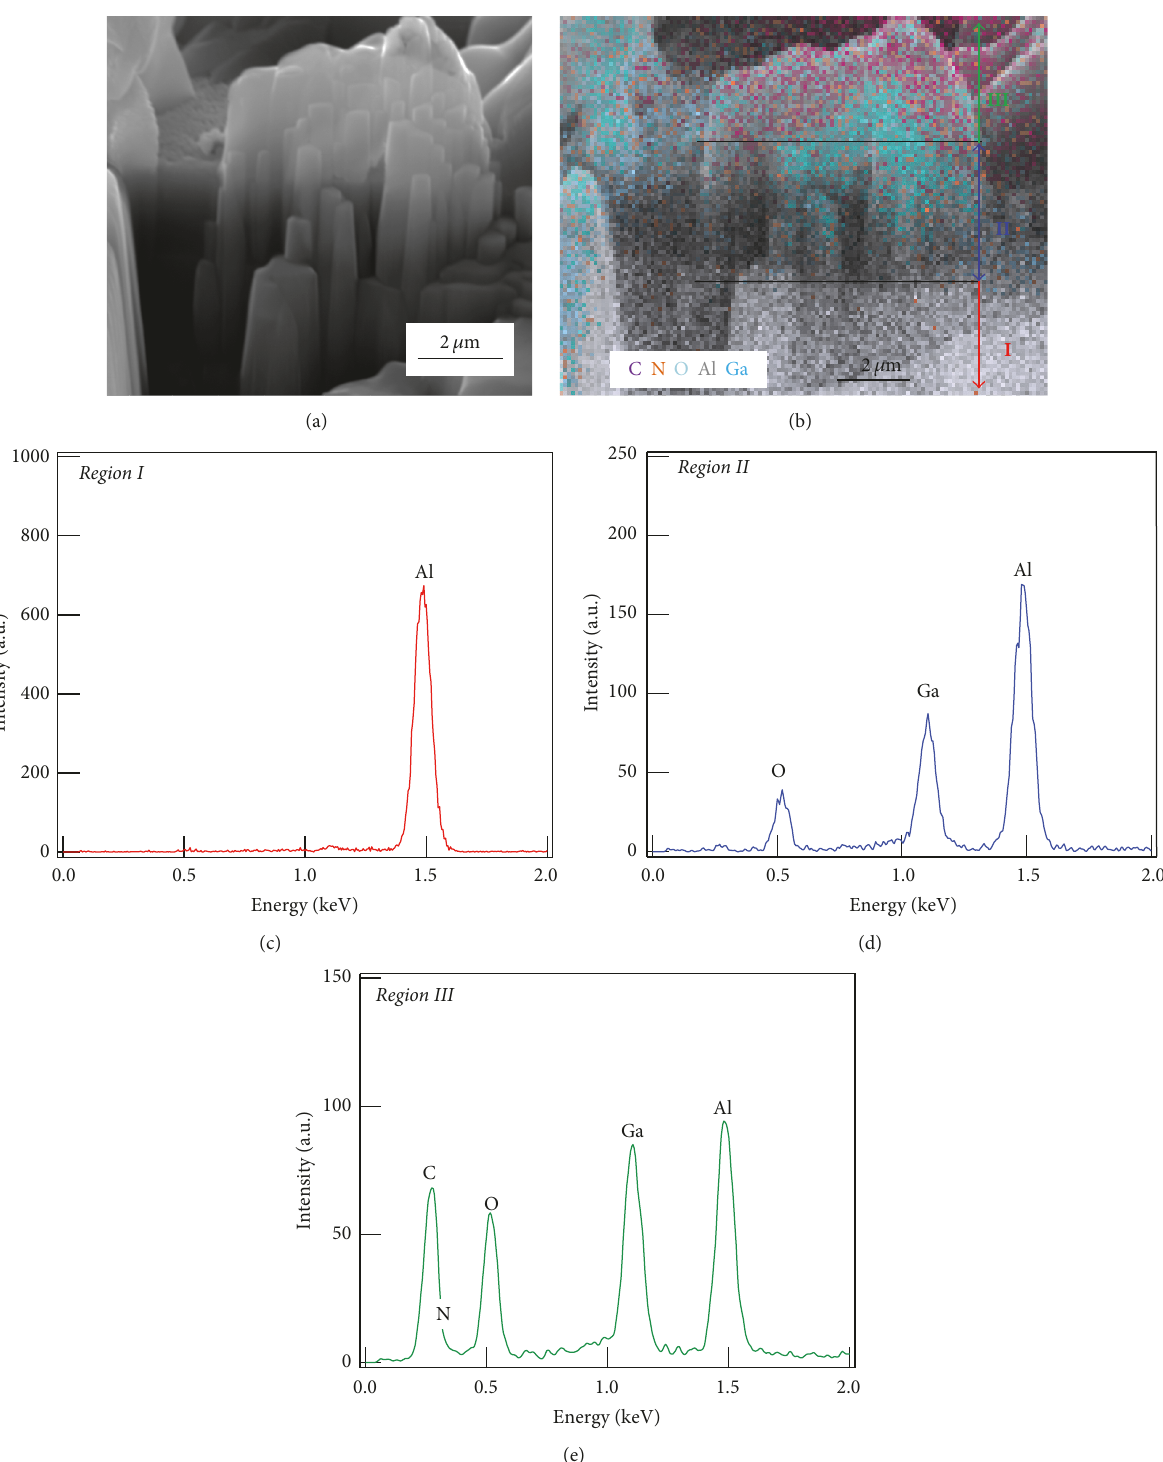
Figure10:Cross-sectionalSEMimage(a)andEDXmappingofAlq 3 microbeltsonthetwo-stepAPA(b),andEDXspectra(c)to(e),observed in different